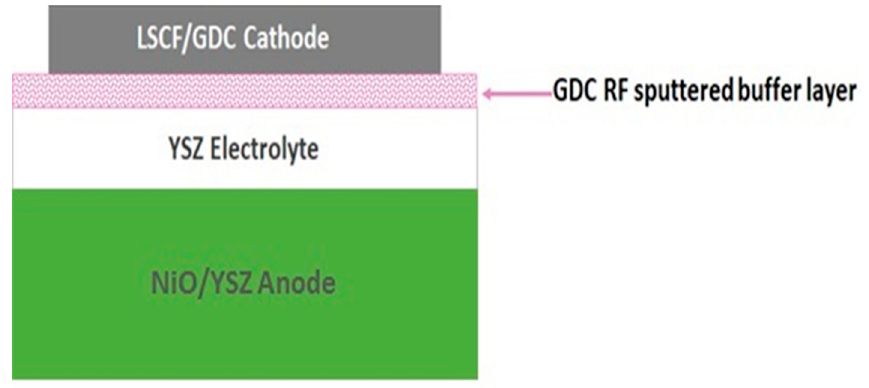
Figure 13. Schematic of the complete sputter-deposited cell.